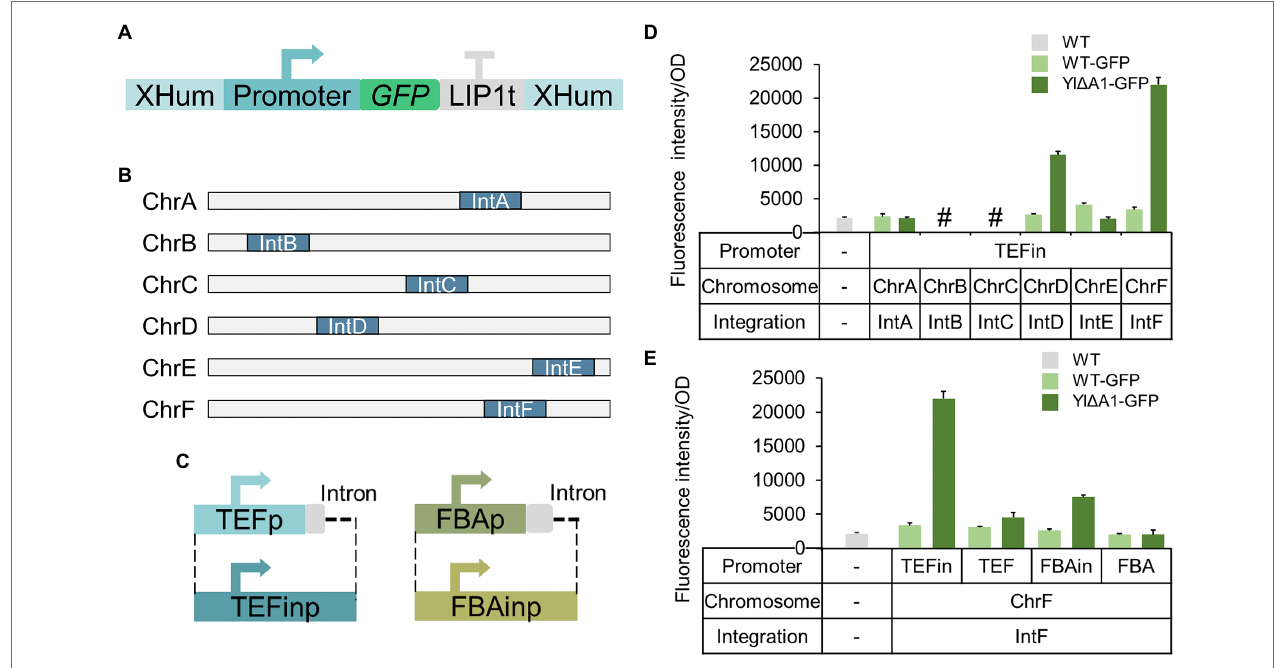
FIGURE 7 | Additional regularities for enhanced expression of exogenous protein. (A) Schematic diagram of transformed fragments with different promoters and homologous arms. (B) Schematic diagram of the distribution of IntX integration sites on the chromosome in Y. lipolytica . (C) Schematic diagram of the promoters with or without intron sequences. (D) The impact of different integration sites on protein expression from A1 disruption. Characterization of protein expression by green fluorescence intensity. The octothorpe (#) indicated the integration failure of sfGFP gene on chromosome B and C. (E) The impact of different promoters on protein expression from A1 disruption. Characterization of protein expression by green fluorescence intensity. All strains were cultured in SC-Leu medium. Values are the mean of three biological replicates standard deviation ( n = 3) after 48